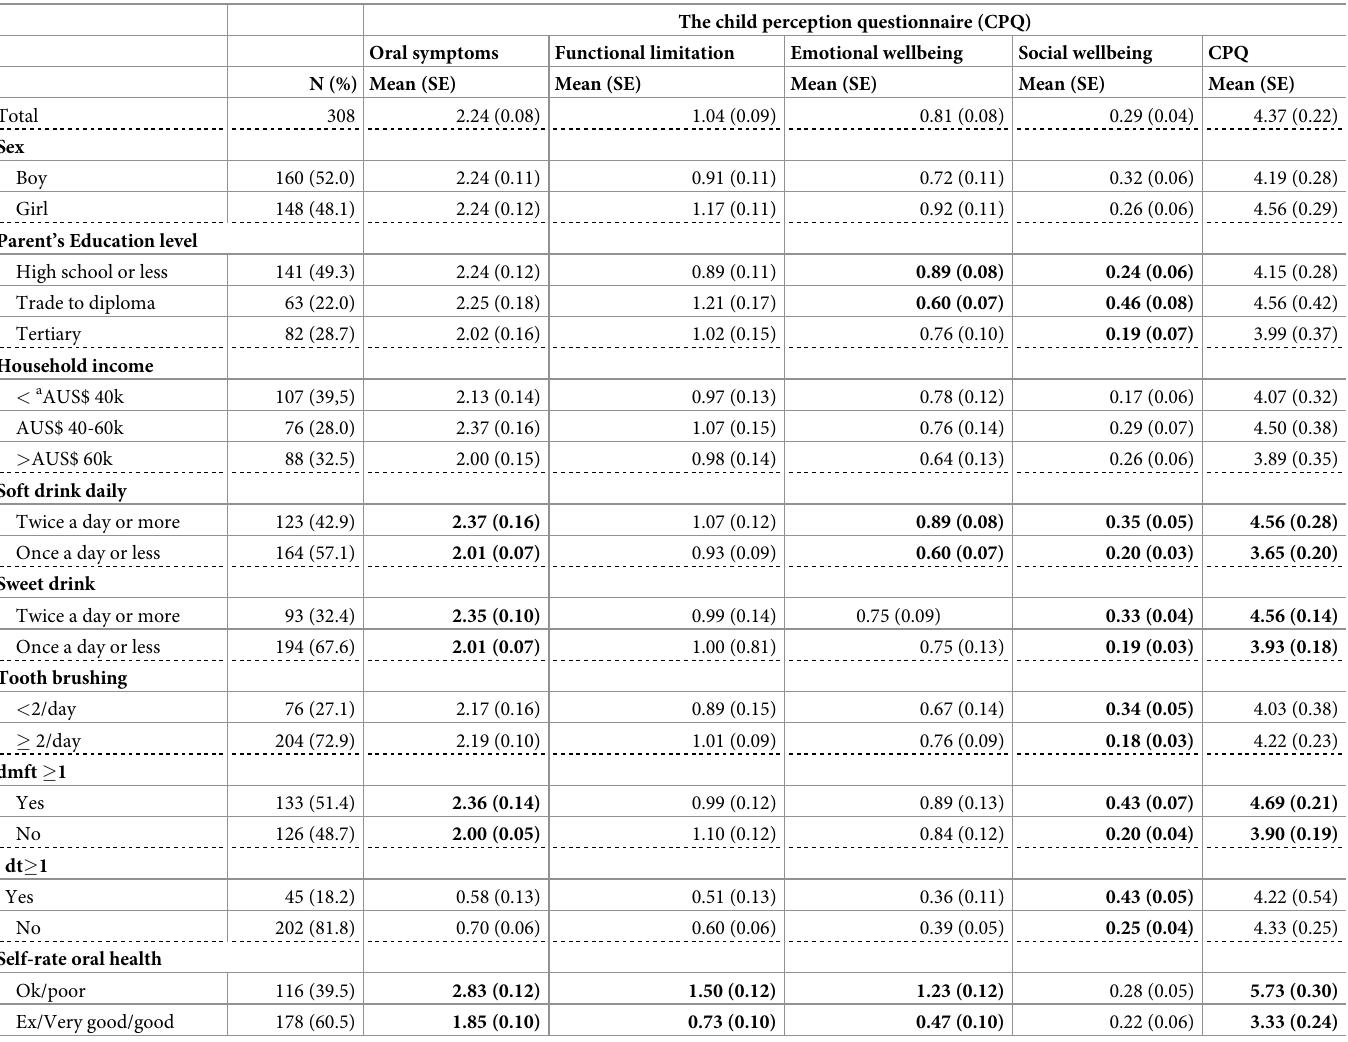
Table 7. Mean (SE) scores for 8-item CPQ and individual items by sample characteristics among children aged 8–10 years.